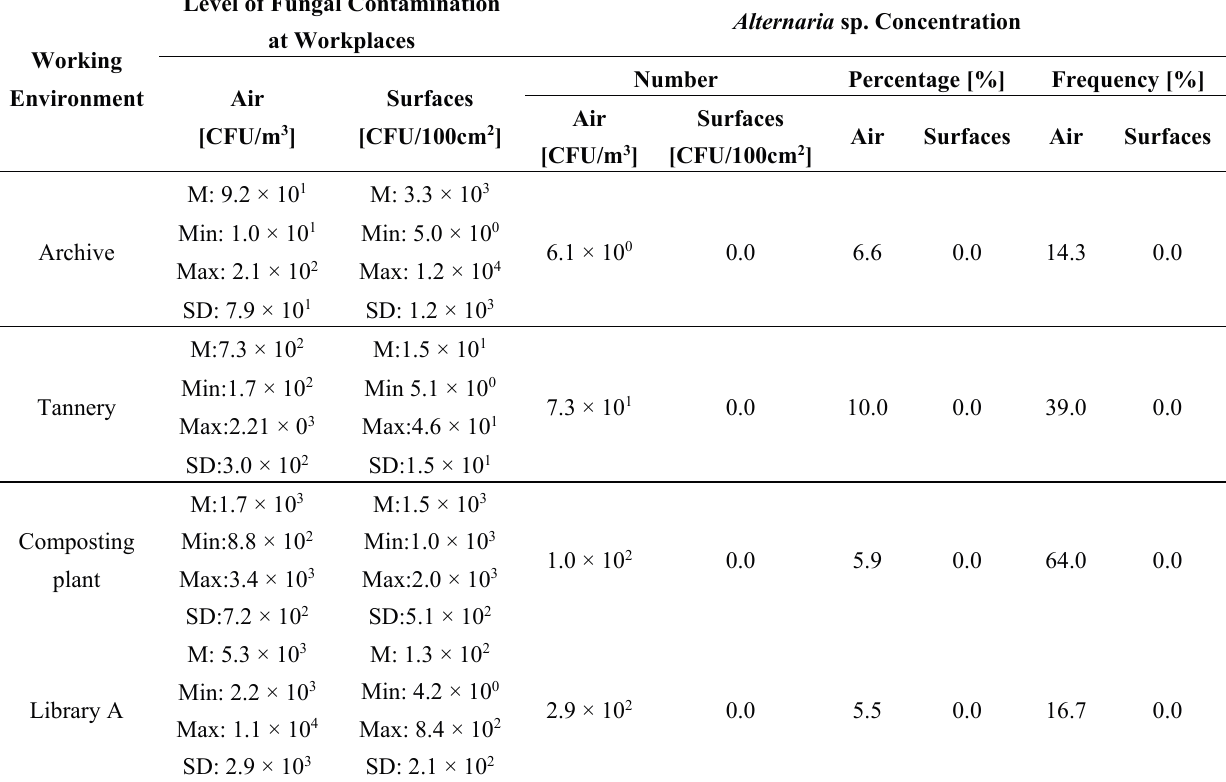
Table 4. Mold contamination of tested